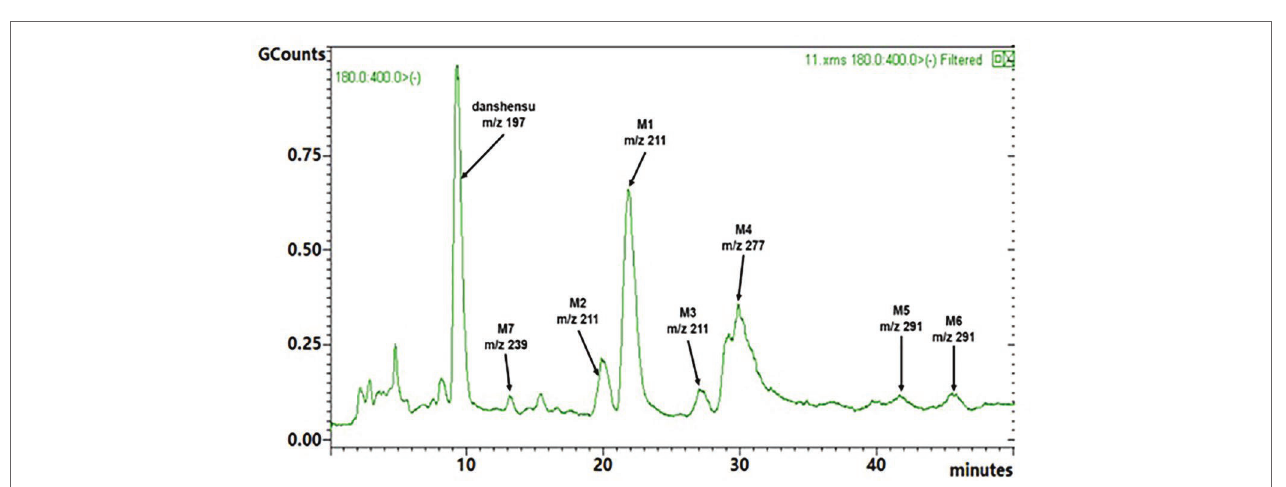
FIGURE 4 | TIC of rat urine sample after intravenous administration of 30 mg/kg sodium danshensu.